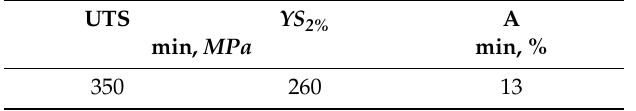
Table 1. Selected strength properties of the test material according to EN 485-2 + A1:2018-12